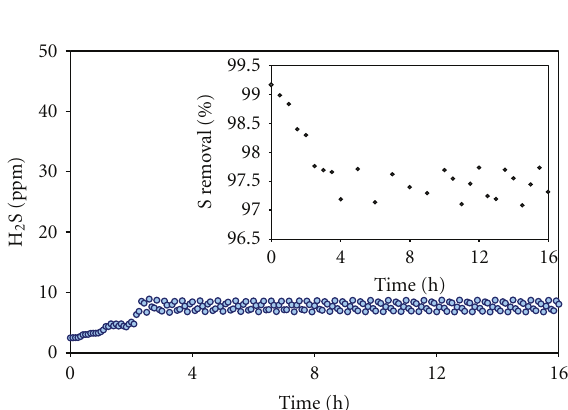
Figure 12: Evidence of sulfur pickup propensity of pure GDC at 800 ◦